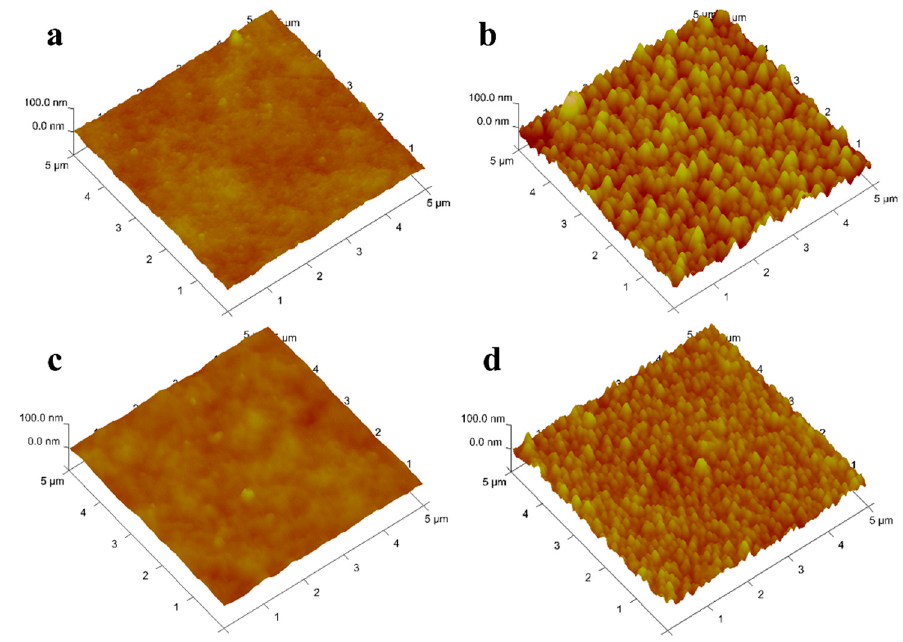
Figure 6. AFM images of four NF membranes ( a ) DK; ( b ) DL; ( c ) NF270; ( d ).